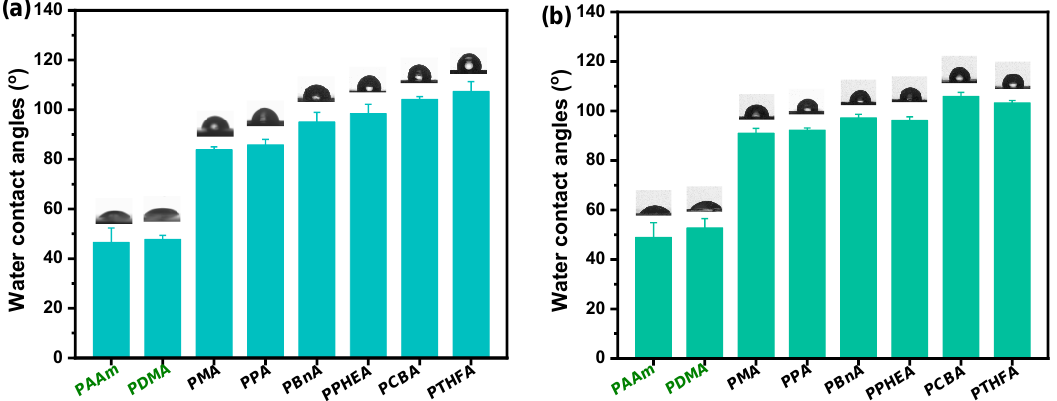
Figure 3. The static water contact angles of the hydrogels with the different chemical structures and water content: ( a ) various hydrogels obtained by the direct solvent exchange of as-prepared organo- gels after polymerization; ( b ) various hydrogels obtained by the solvent exchange of organo-gels with equilibrium state in DMSO.